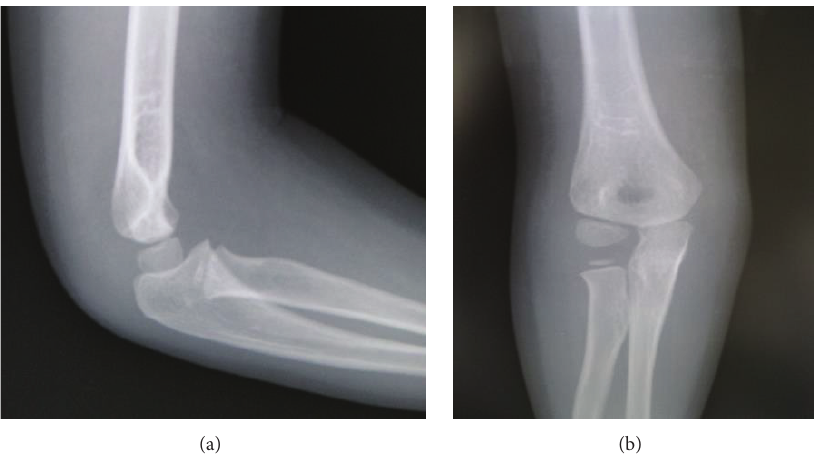
Figure 1: Plain X-rays of the right elbow. There is no sign of osteolysis. (a) Lateral view. (b) Anteroposterior view.